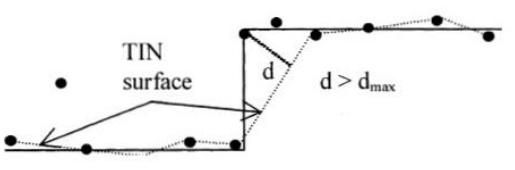
Figure 4. Edge cutting (Axelsson, 2000).